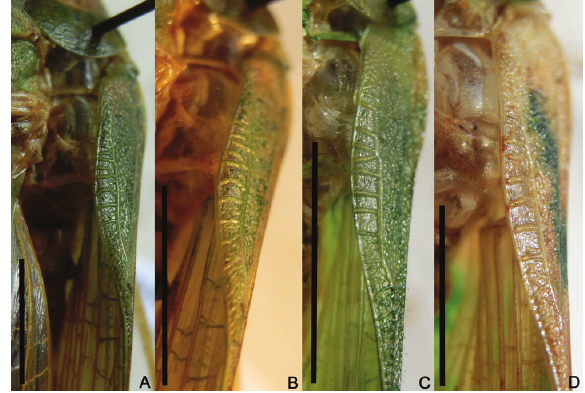
Figure 6. Right tegmen with stridulatory veins of female Gona- toxia species A . G. maculata B G. immaculata C G. helleri sp. n. D G. furcata sp. n. Scale bars 5 mm. Males (n = 8): Total length of body: 23–28 (holotype 30); median length of pronotum: 6.1–6.6 (holotype: 7); length of hind femur: 25–27 (holotype 25); length of teg - mina: 41–43.7 (holotype 41); width of tegmina: 10.3–14 (holotype 11.5).